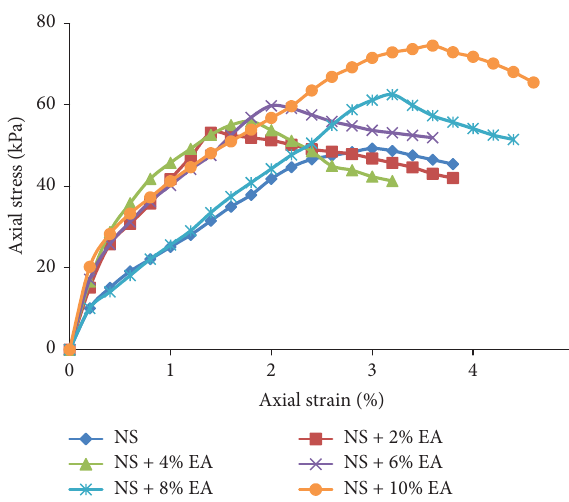
Figure 3: Unconfned compressive strength curves of natural soil (NS) treated with Enset ash (EA).